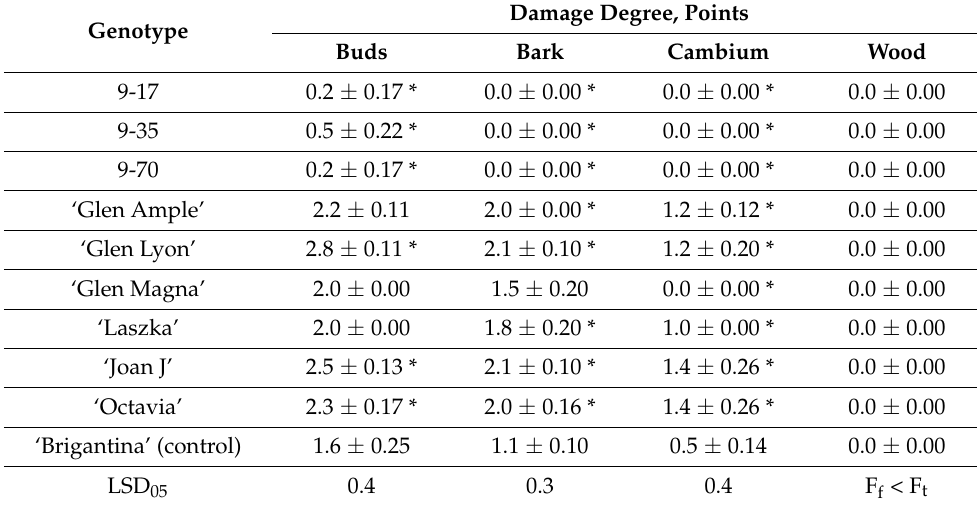
Table 6. Damage to raspberries at − 30 ◦ C after repeated hardening and a three-day thaw of +2 ◦ C (the fourth winter hardiness component) in 2019–2021.